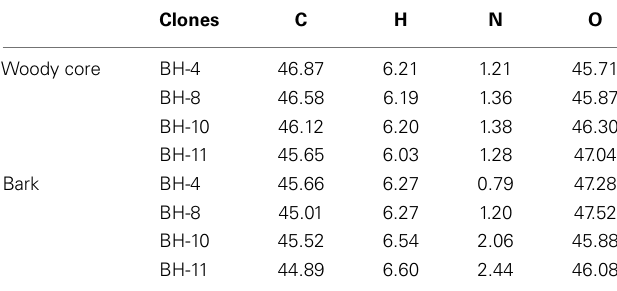
Table 3 | Elementary composition of wood and bark [unit: % (wt/wt)].